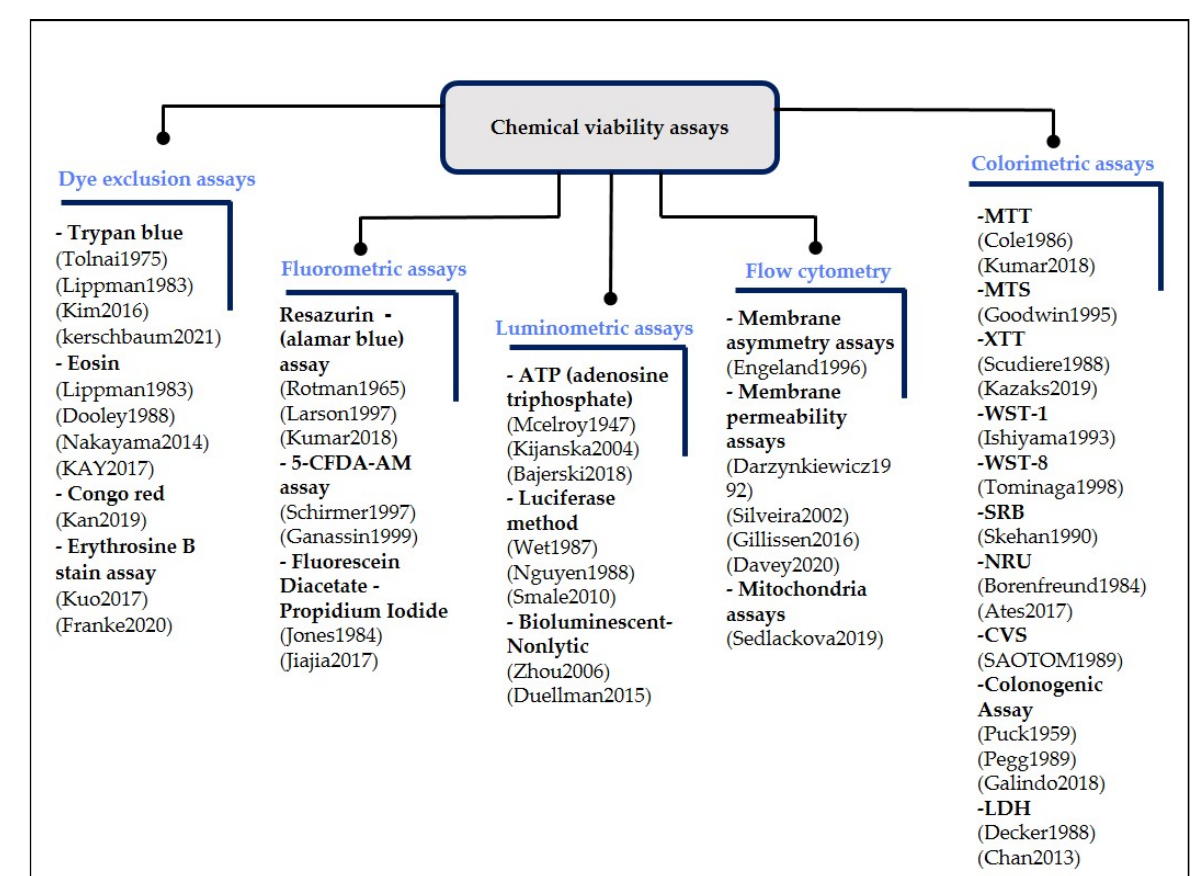
Figure 2. The broad classification of chemical viability assays and the various techniques they involve.